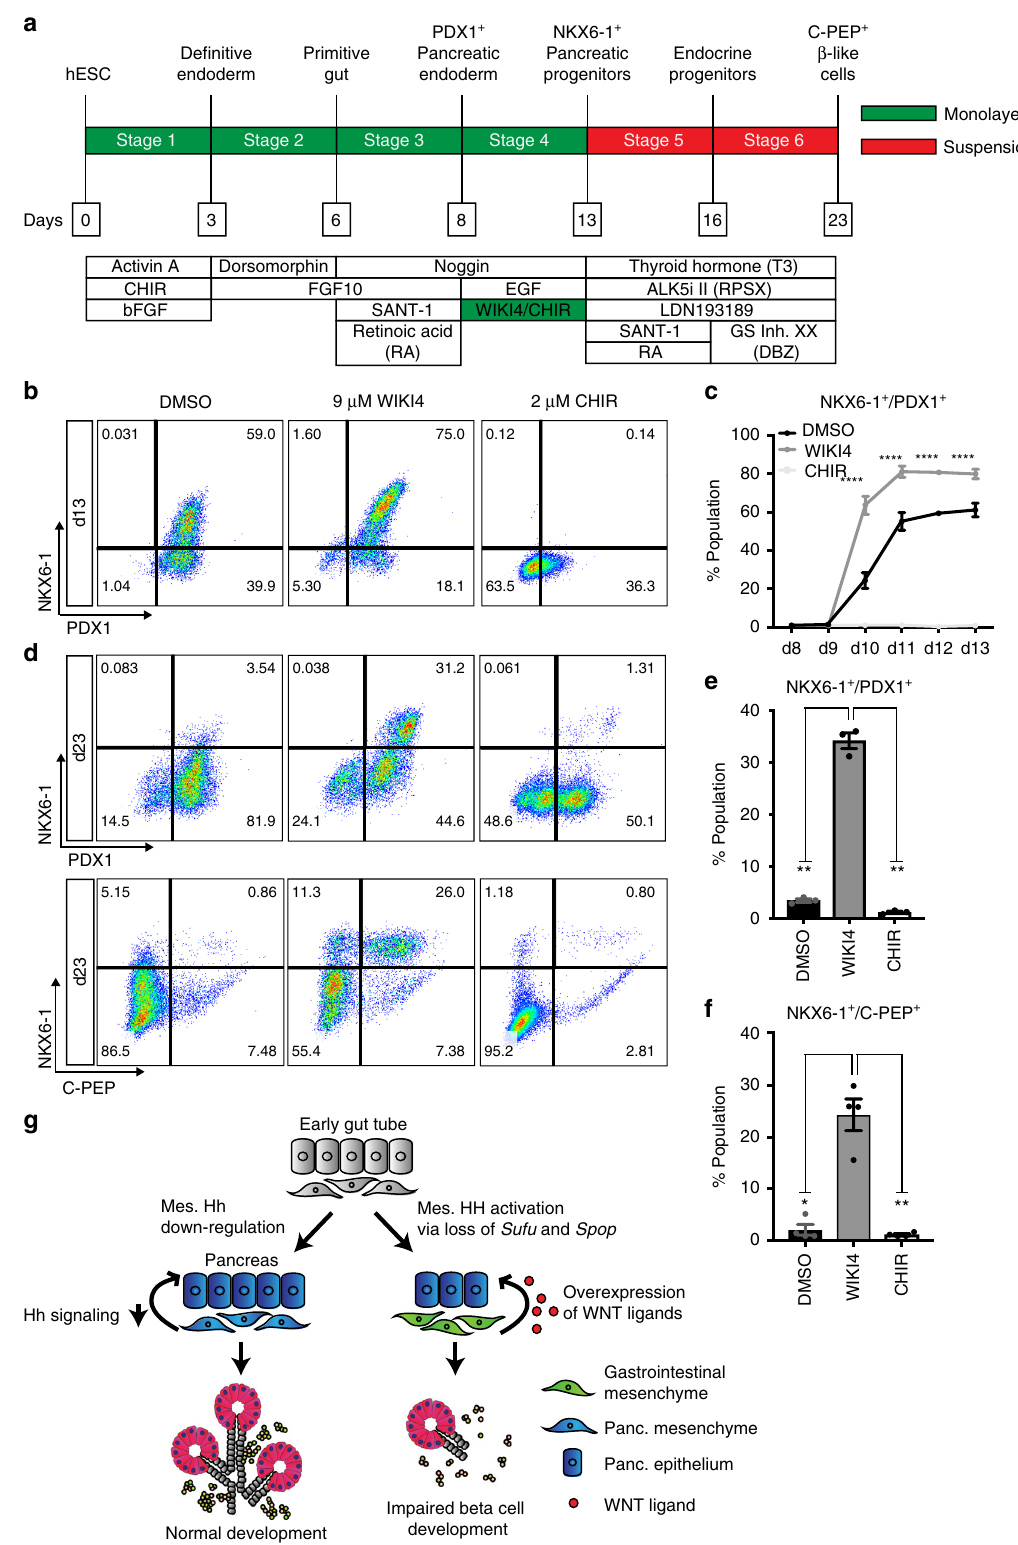
Wnt are inhibitory to pancreatogenesis, but how Wnt signaling is regulated was unknown. Our study demonstrates that upregula- tion of Hh signaling activates mesenchymal Wnt signals, pro- viding mechanistic insight into interactions between the Hh and Wnt